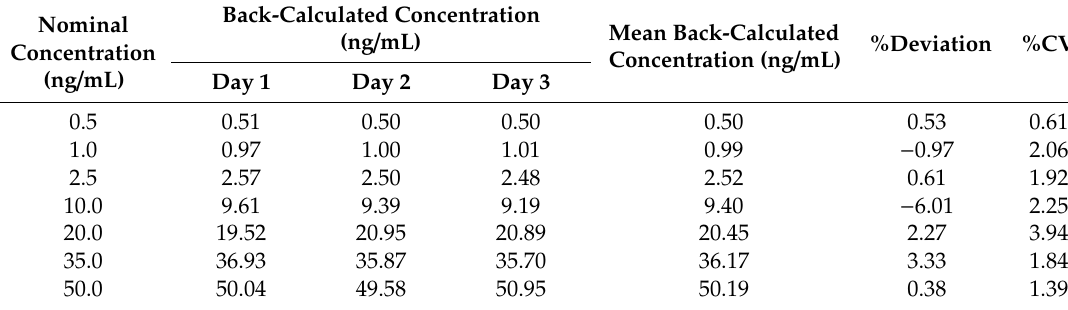
Table 1. Mean inter-day back-calculated standard and standard curve results ( n = 3).